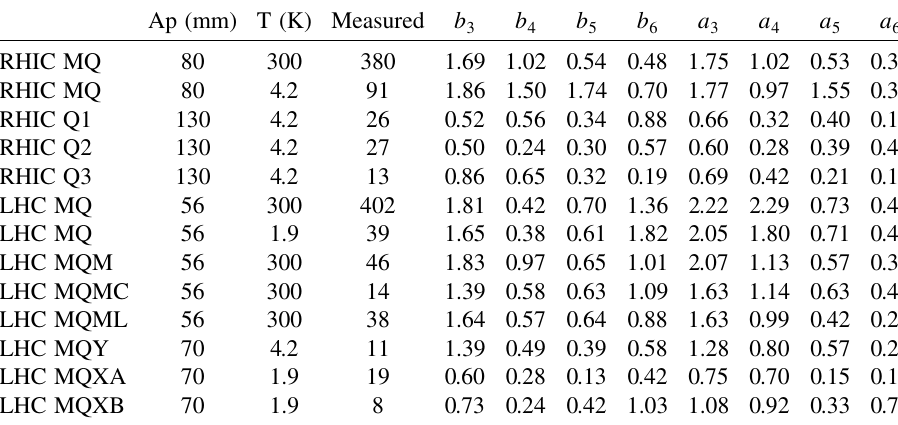
TABLE II. Standard deviation of measured multipoles in RHIC and LHC quadrupoles, reference radius taken as 2 = 3 of